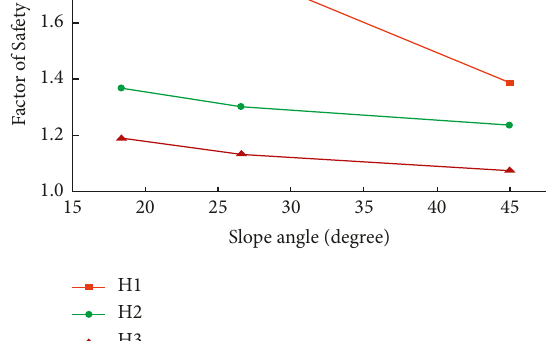
Table 4: Material property of asphalt concrete. Asphalt